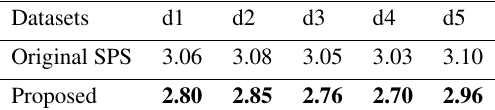
Table 2. Time-consuming comparison(in seconds)